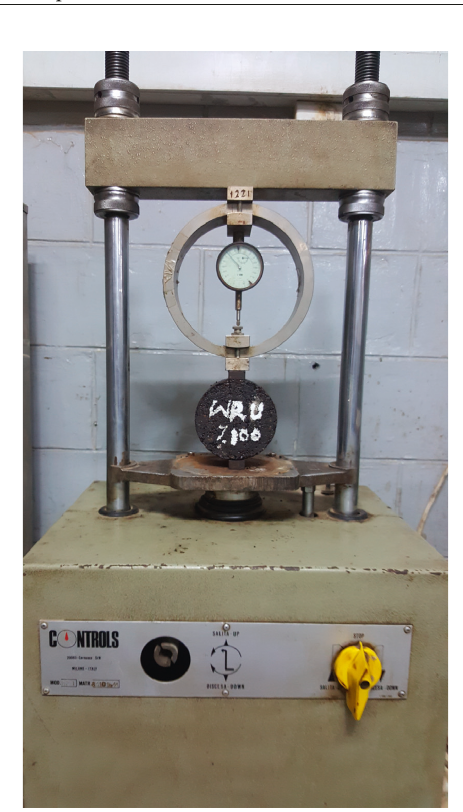
Figure 8: Indirect tension test for the WRU